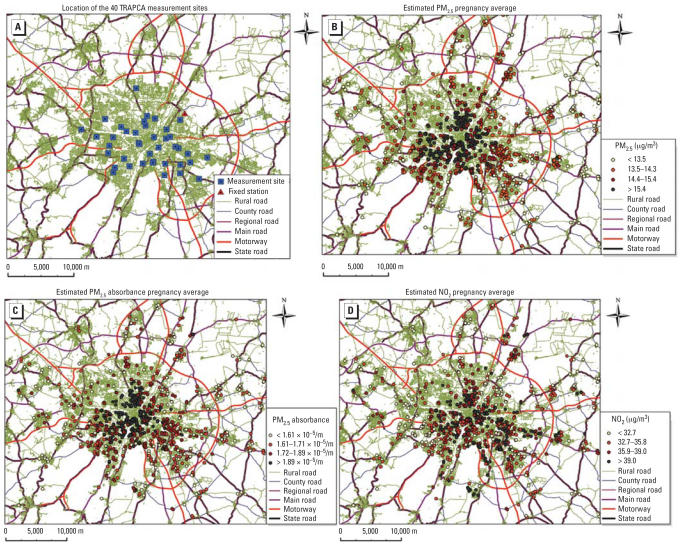
Map of the study area indicating (A) the location of the 40 TRAPCA measurement sites and of Johanneskirchen fixed air quality monitoring station (used to seasonalize the exposure model), and (B,C,D) the home addresses of the women during pregnancy and the estimated exposure levels (pregnancy averages). (B) PM2.5 levels; (C) PM2.5 absorbance; (D) NO2 levels. To improve readability, the study area furthest from the city center was not represented.